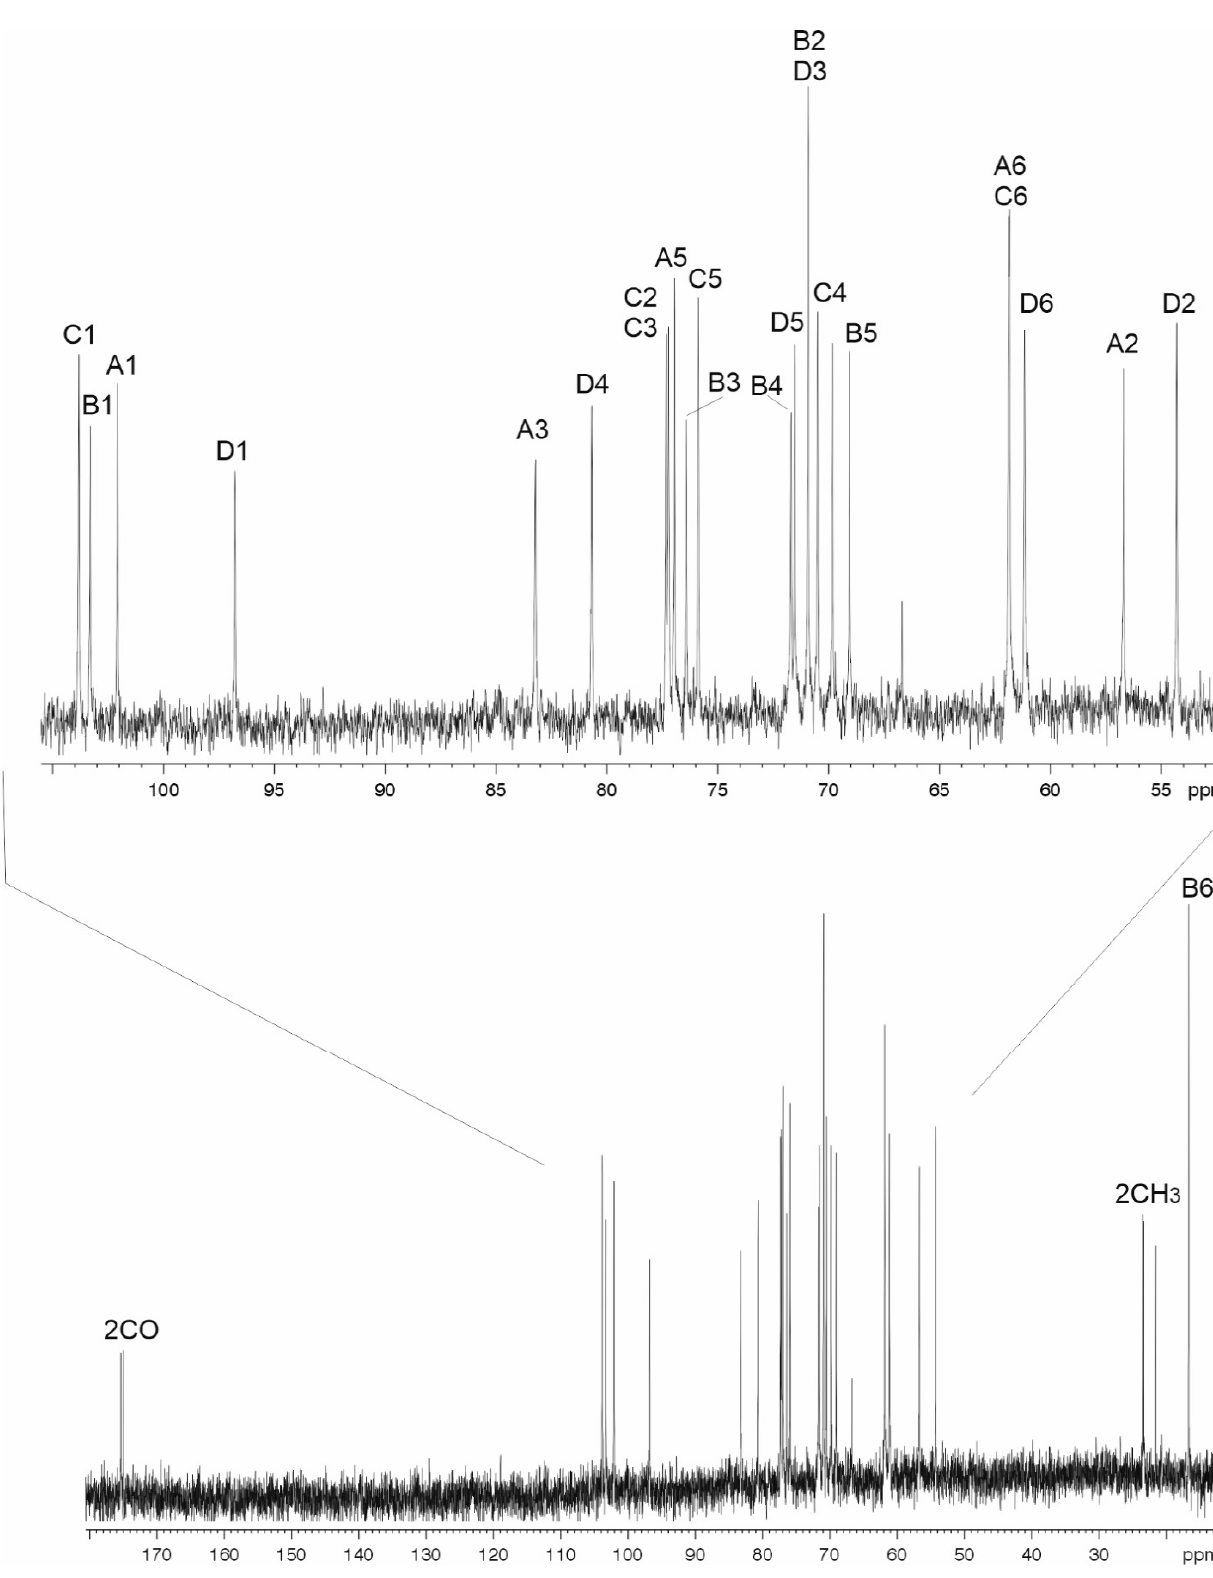
Figure 3. 13 C NMR spectrum of the CPS of A. baumanii K106 (48-1789). Figure 3. 13C NMR spectrum of the CPS of A. baumanii K106